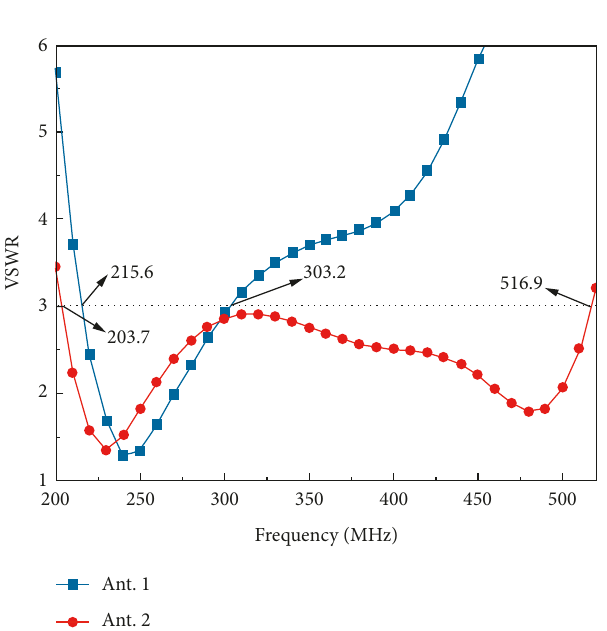
Figure 3: The simulated VSWR of Ant. 1 and Ant. 2.